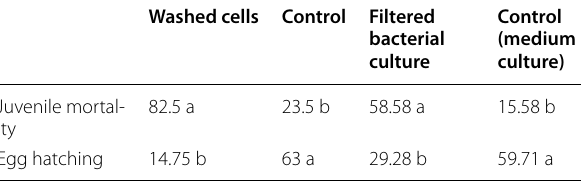
Table 1 Nematicidal effect of cells suspension and filtered medium culture of strain AzBw1